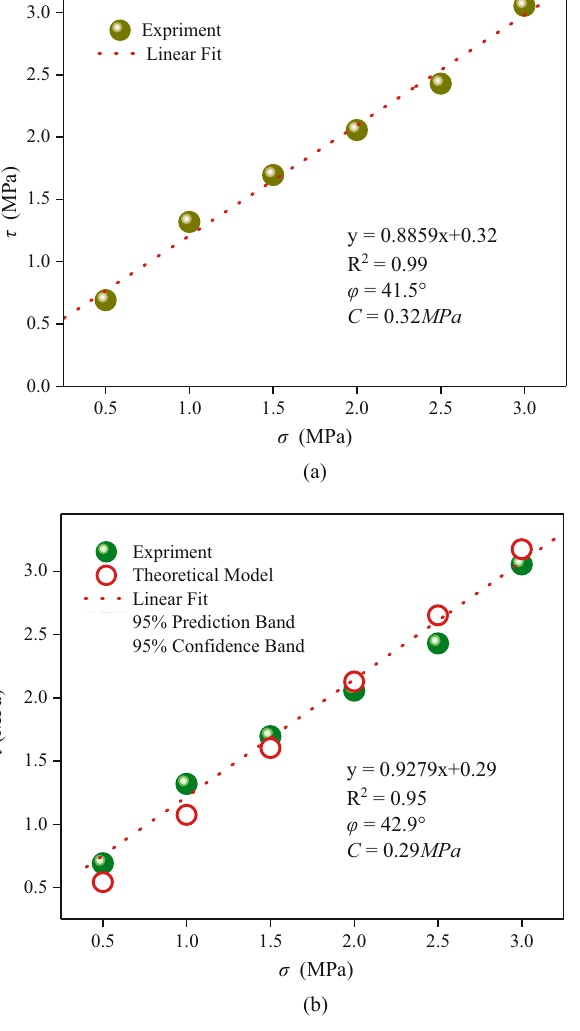
Figure 16: Relationship curves of τ – σ under di ff erent methods: ( a ) based on prediction model and ( b ) based on shear